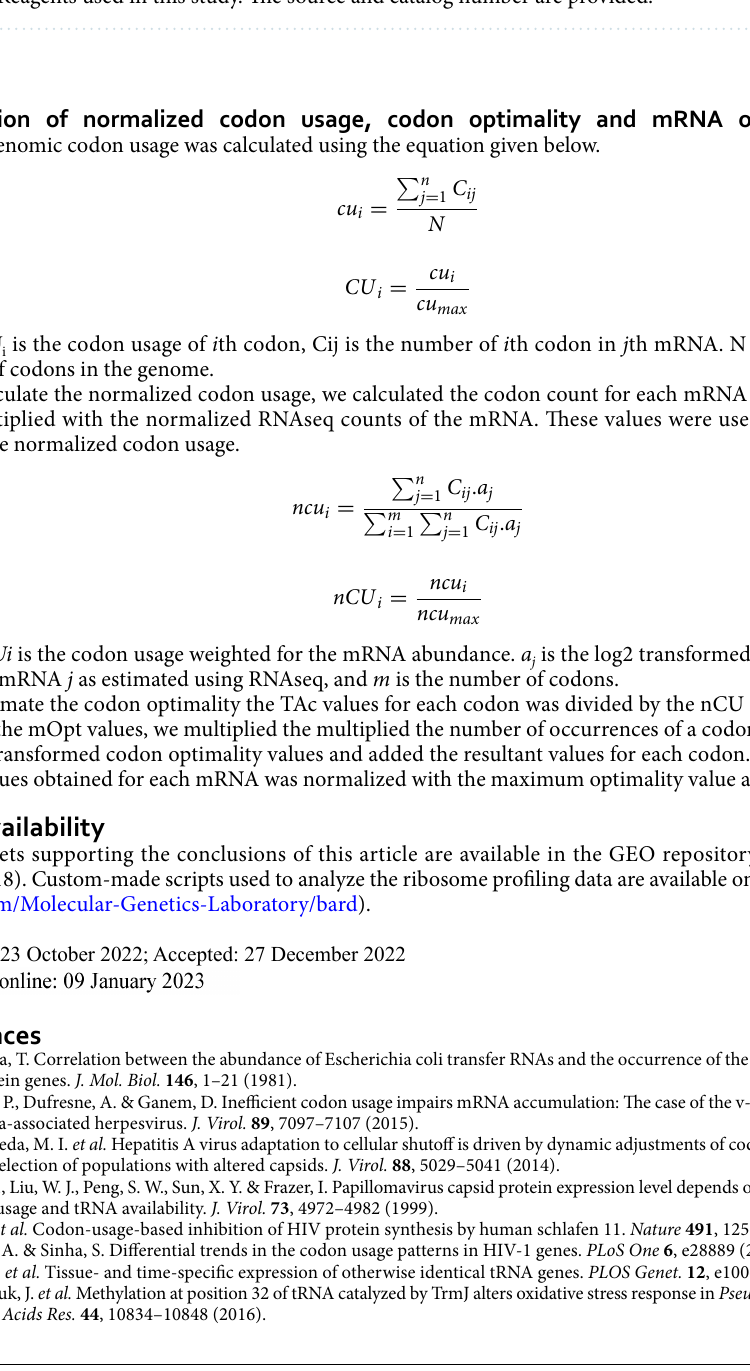
Table 1. Reagents used in this study. The source and catalog number are